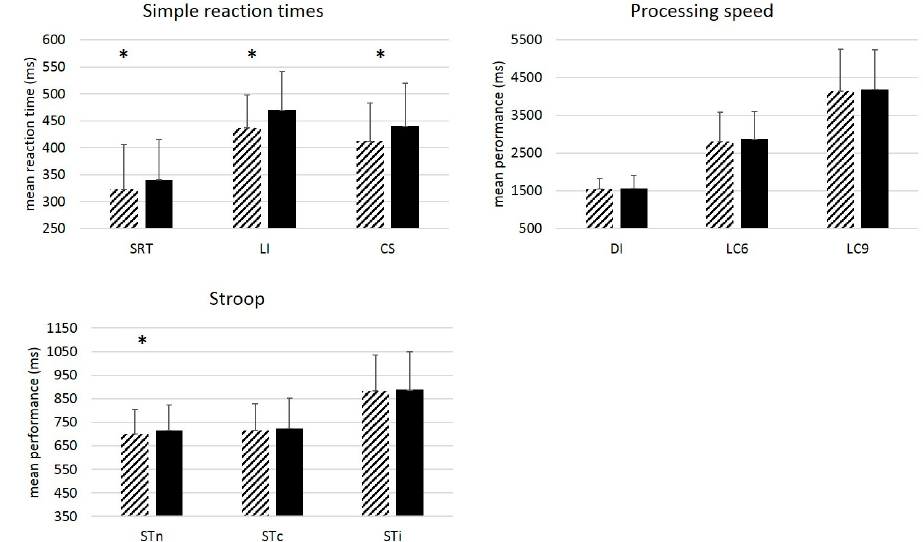
Figure 1. Mean performance (ms) by Task and Wave. Simple RT tasks (SDT, LI, CS), Processing speed tasks (DI, LC6, LC9) and Stroop task (STn =neutral condition, STc = congruent condition, STi = incongruent condition). Dashed bars: Wave 1. Plain black bars: Wave 4. Paired t -tests showed significant change in performance for simple tasks only. Error-bars represent standard deviations. * = p < 0.005 (Bonferroni correction).